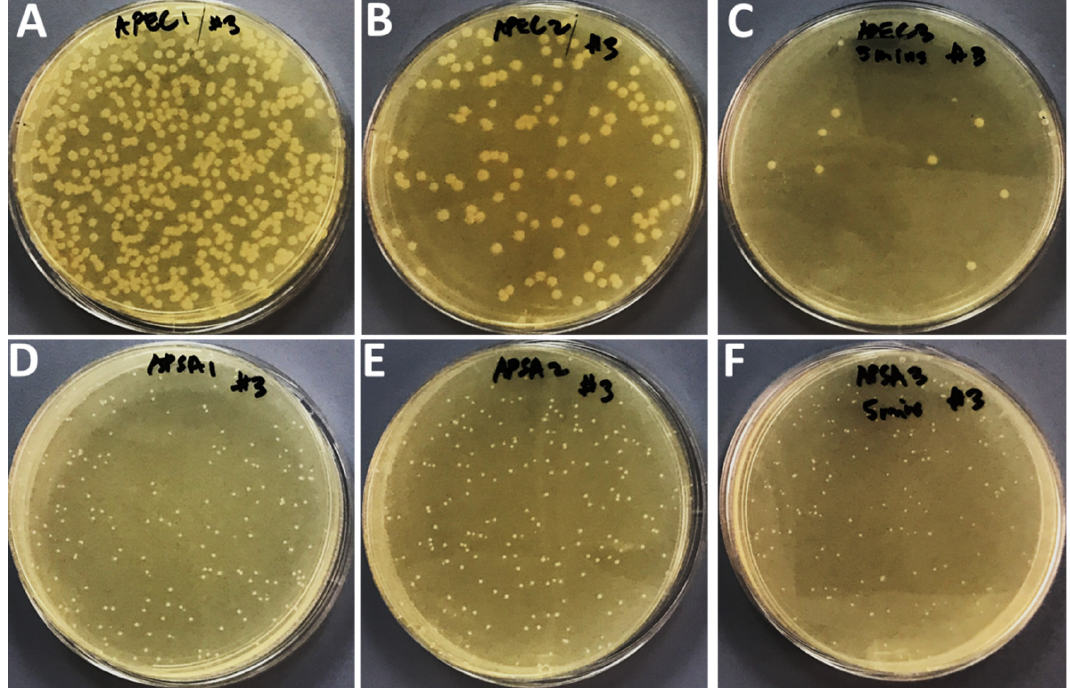
Figure 5. Effects of Ag 3 PO 4 on the growth of E. coli (panel ( A – C )) and S. aureus (panel ( D – F )). ( A , D ); without compound and sonication, ( B , E ) with compound but without sonication, and ( C , F ); with compound and 5 min of sonication.